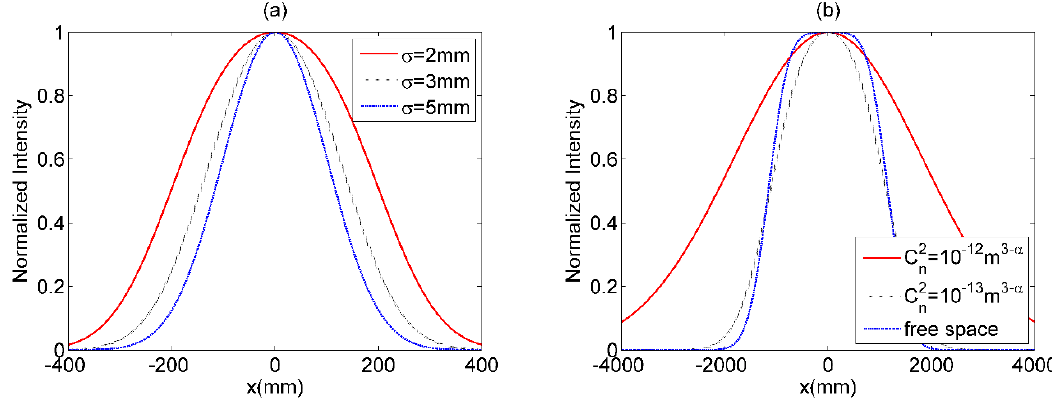
Figure 4. The cross sections of N × D MGSM array beams with N = D = 3 propagating through non-Kolmogorov turbulent atmosphere for C 2 n . ( a ) z = 600 m and ( b ) z = 5000 m. The e ff ects of coherence length, σ , on N × D MGSM array beams with N = D = 3 propagating through non-Kolmogorov turbulent atmosphere are illustrated in Figure 5. As can be found, the MGSM array beams with smaller σ will evolve into a Gaussian beam more rapidly with increasing propagation distance z , and will have a larger spot. To investigate the e ff ective beam size of a Gaussian beam translated by the MGSM array beam, Figure 6 gives the e ff ective beam size W x of the Gaussian beam for di ff erent C 2 and σ . One can see that W x of a Gaussian beam obtained by a MGSM array beam will n increase with the increase of C 2 or the decrease of σ . n